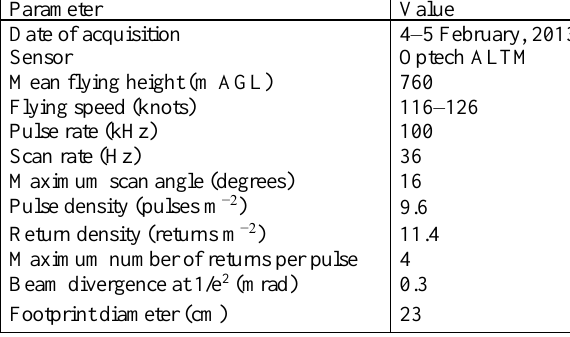
Table 2. Characteristics of the LiDAR